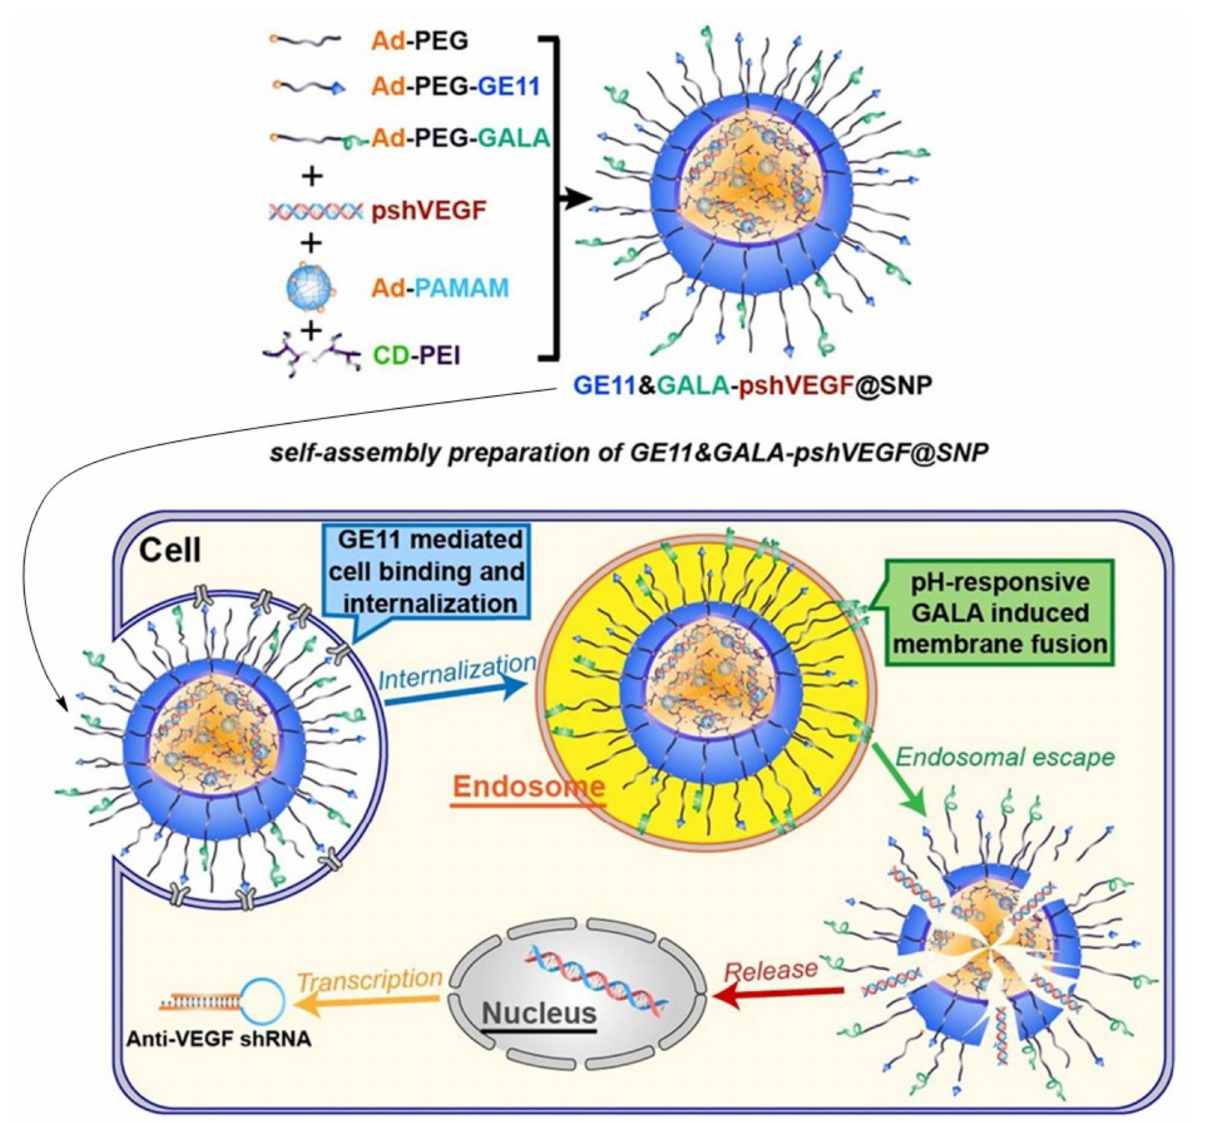
Figure 8. Schematic representation of the preparation and formation of self-assembly nanoparticle and transfection processes inside the cell. With the permission of